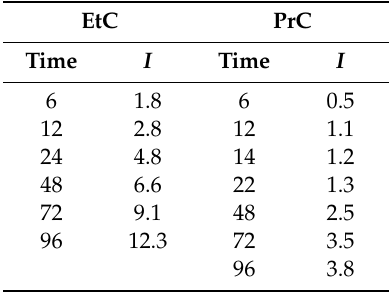
Table 2. Intensity of the ~1075 cm − 1 band ( I , cm − 1 ) of EtC and PrC as function of time